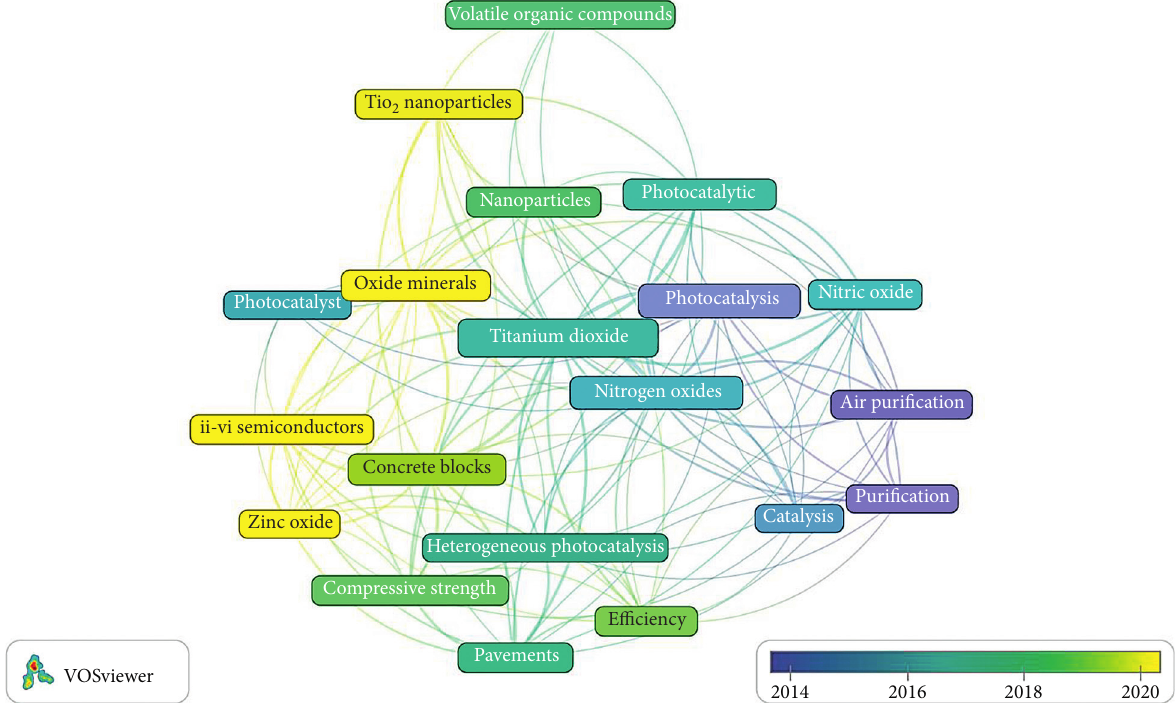
Figure 1: Scientometric analysis of research trends of photocatalytic-concrete